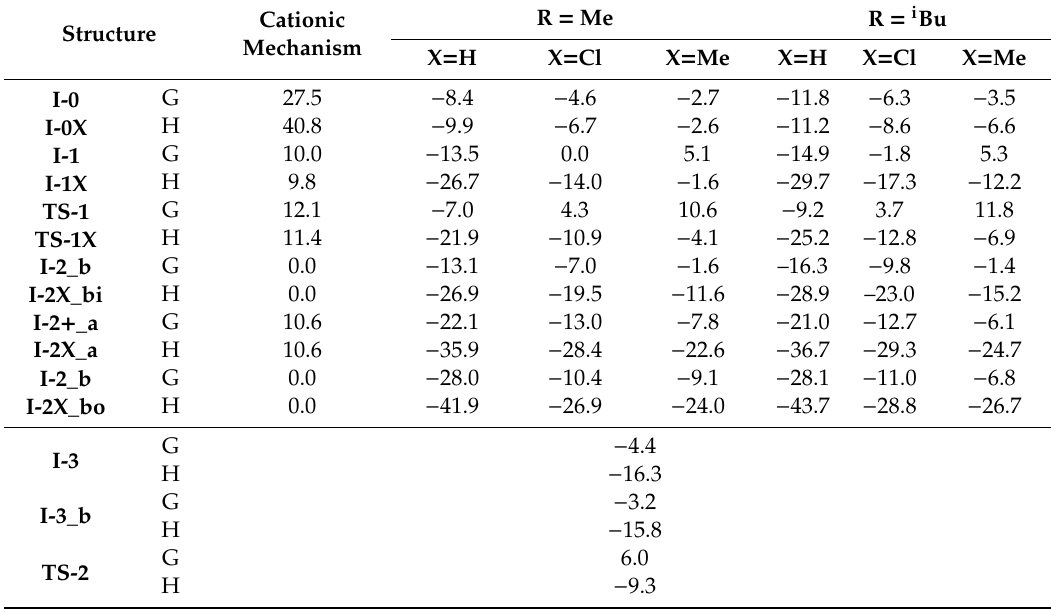
Table 1. Calculated free energies and free enthalpies (kcal/mol) of stationary points and transition states for mononuclear and binuclear reaction mechanisms. 1